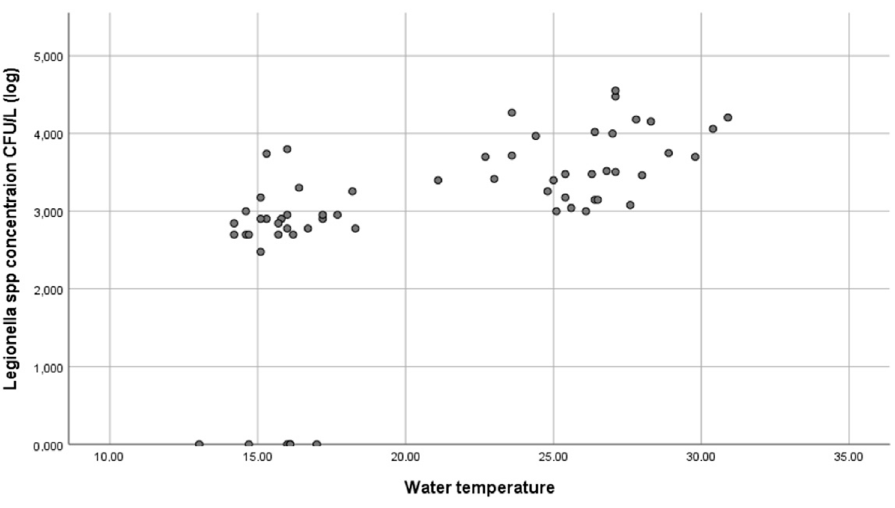
Figure 4. Legionella spp. concentration (on a logarithmic scale) correlated with water temperature.